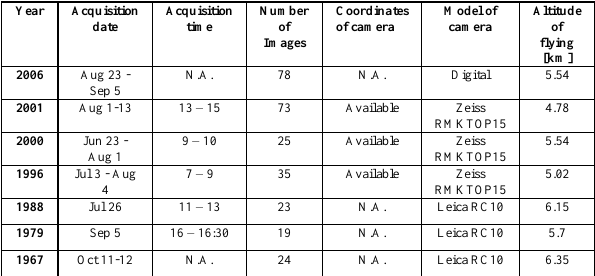
Table 1 . Information on photogrammetric data sets over Val Veny that were acquired from the IGNF online